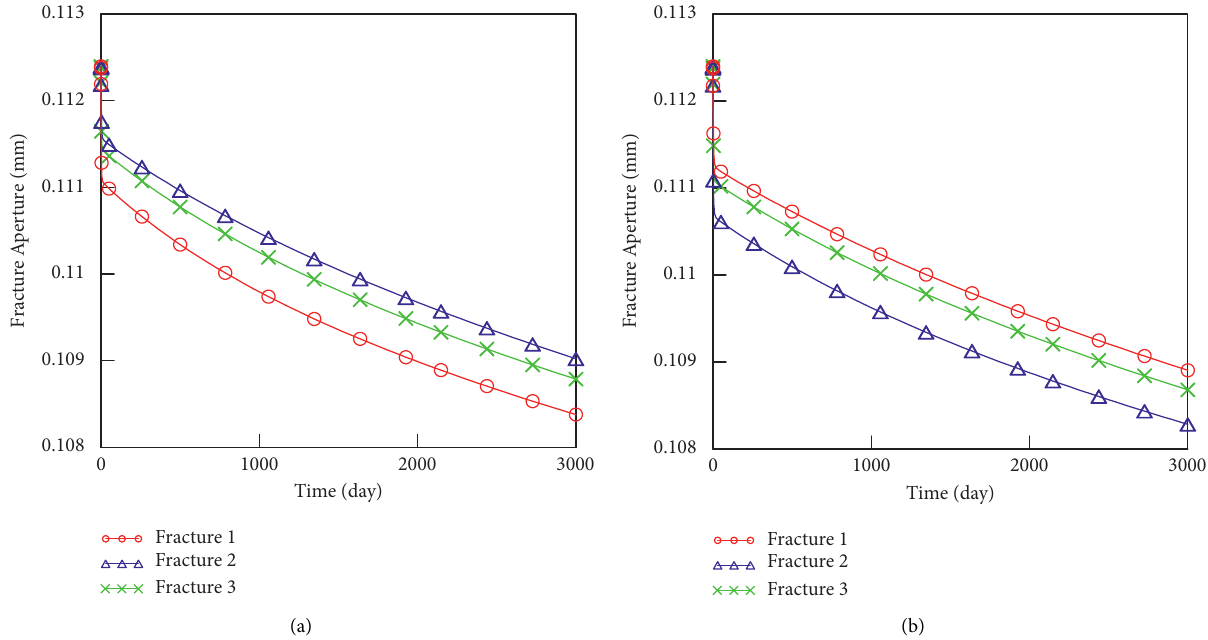
Figure 15: Effect of matrix permeability anisotropy on fracture aperture: (a) k